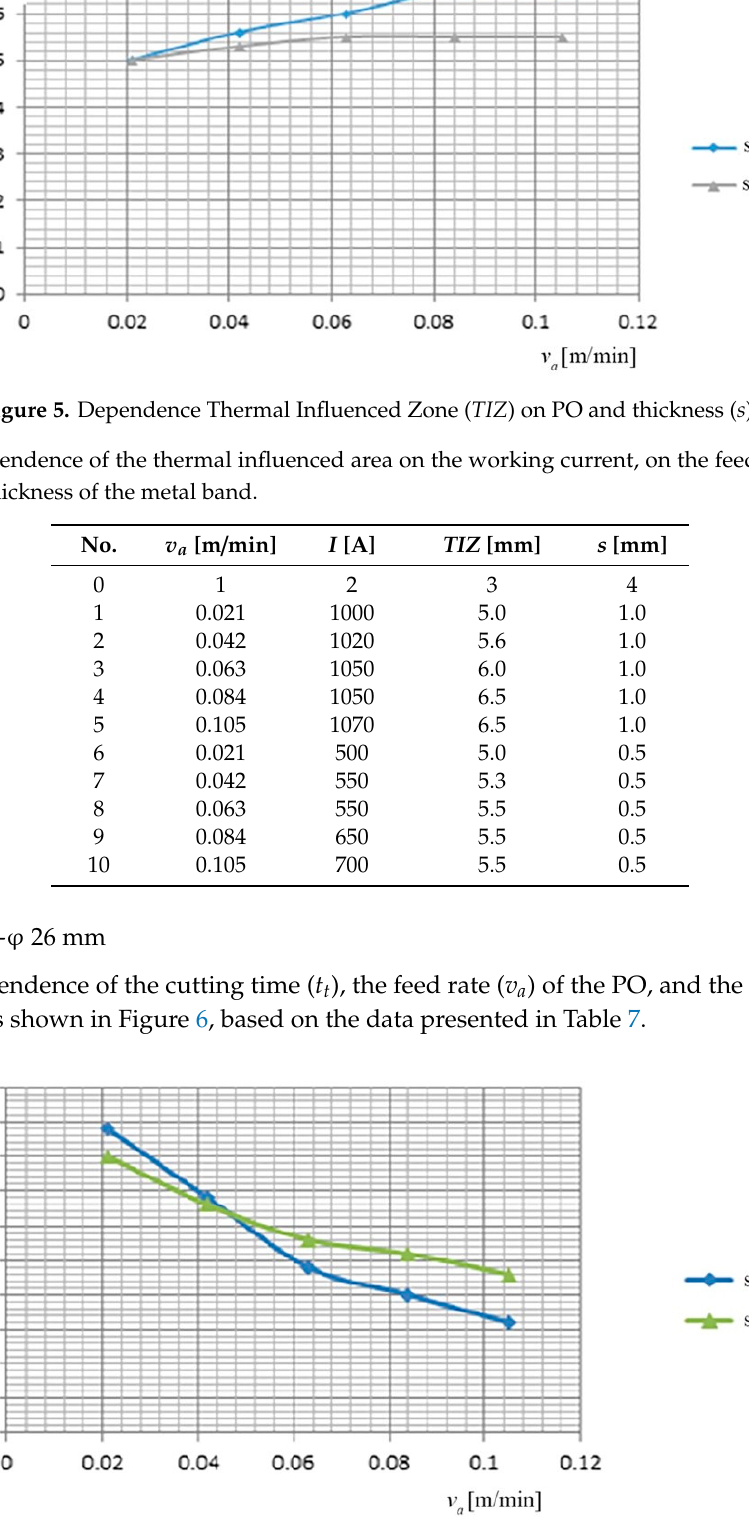
Figure 6. Dependence on the cutting time ( t t ), the feed rate ( v a ) of the PO, and the thickness of the metal band ( s ).